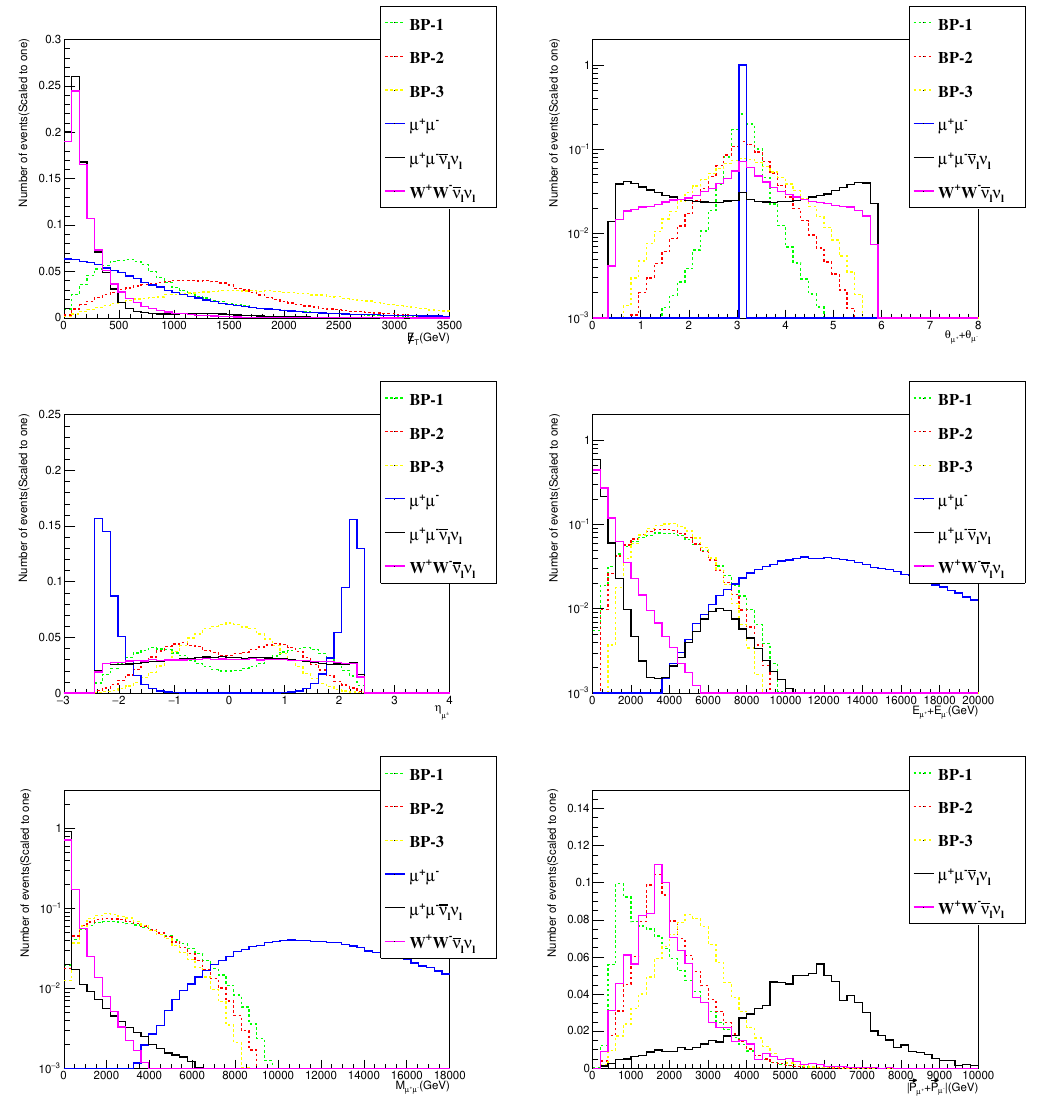
Figure 7 . Normalized distribution of missing transverse energy (cid:0) E T (up-left panel), dimuon acollinearity θ + θ (up-right panel), pseudorapidity η (middle-left panel), dimuon energy µ + µ − µ ± E + E (middle-right panel), dimuon invariant mass M (down-left panel), vector sum µ + µ − µ + µ − momentum of dimuon | ~P + ~P | (down-right panel) for benchmark points (dashed lines) and µ + µ − √ corresponding backgrounds (solid lines) at the s = 14 TeV muon collider. Variable | ~P + ~P | is µ + µ − shown after applying cuts from equation (5.9) to (5.14), while the other five variables are shown with only the cuts in equation